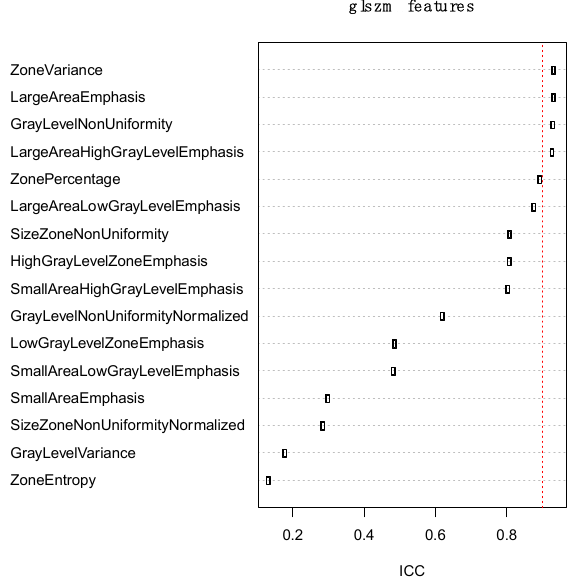
Figure 7. Robustness of second-order GLSZM features across segmentations. Pyradiomics computes 16 second-order GLSZM features. The robustness (ICC) is above 0.8, per all values of distance and binw, only for 11 of them. Robustness of many features across segmentations is dependent on bin-width but not on distance (the vertical dashed red line indicates the 0.9 threshold).